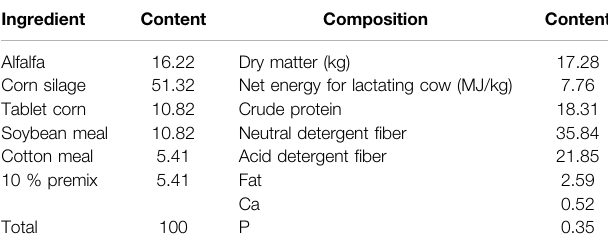
TABLE 1 | Ingredient and nutrient composition in diet (dry matter basis)